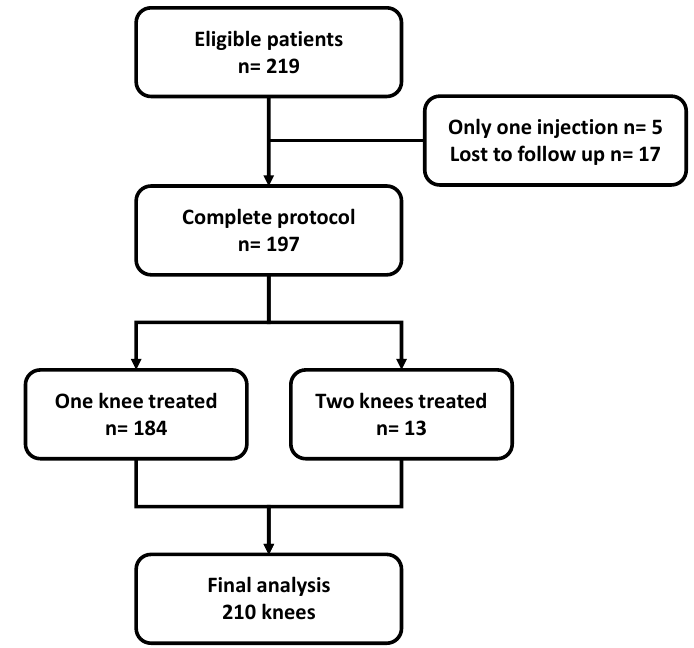
Figure 1. Flowchart of the study. n = number of patients. Table 1. Characteristics of the study population.